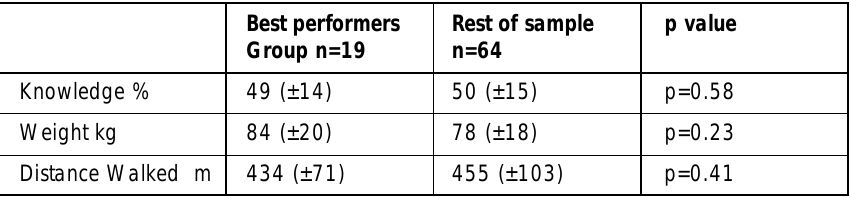
Table 1: Baseline Data